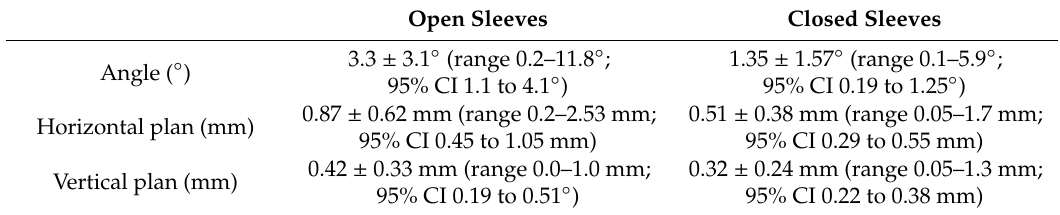
Table 2. Sub-group analysis of the final implant